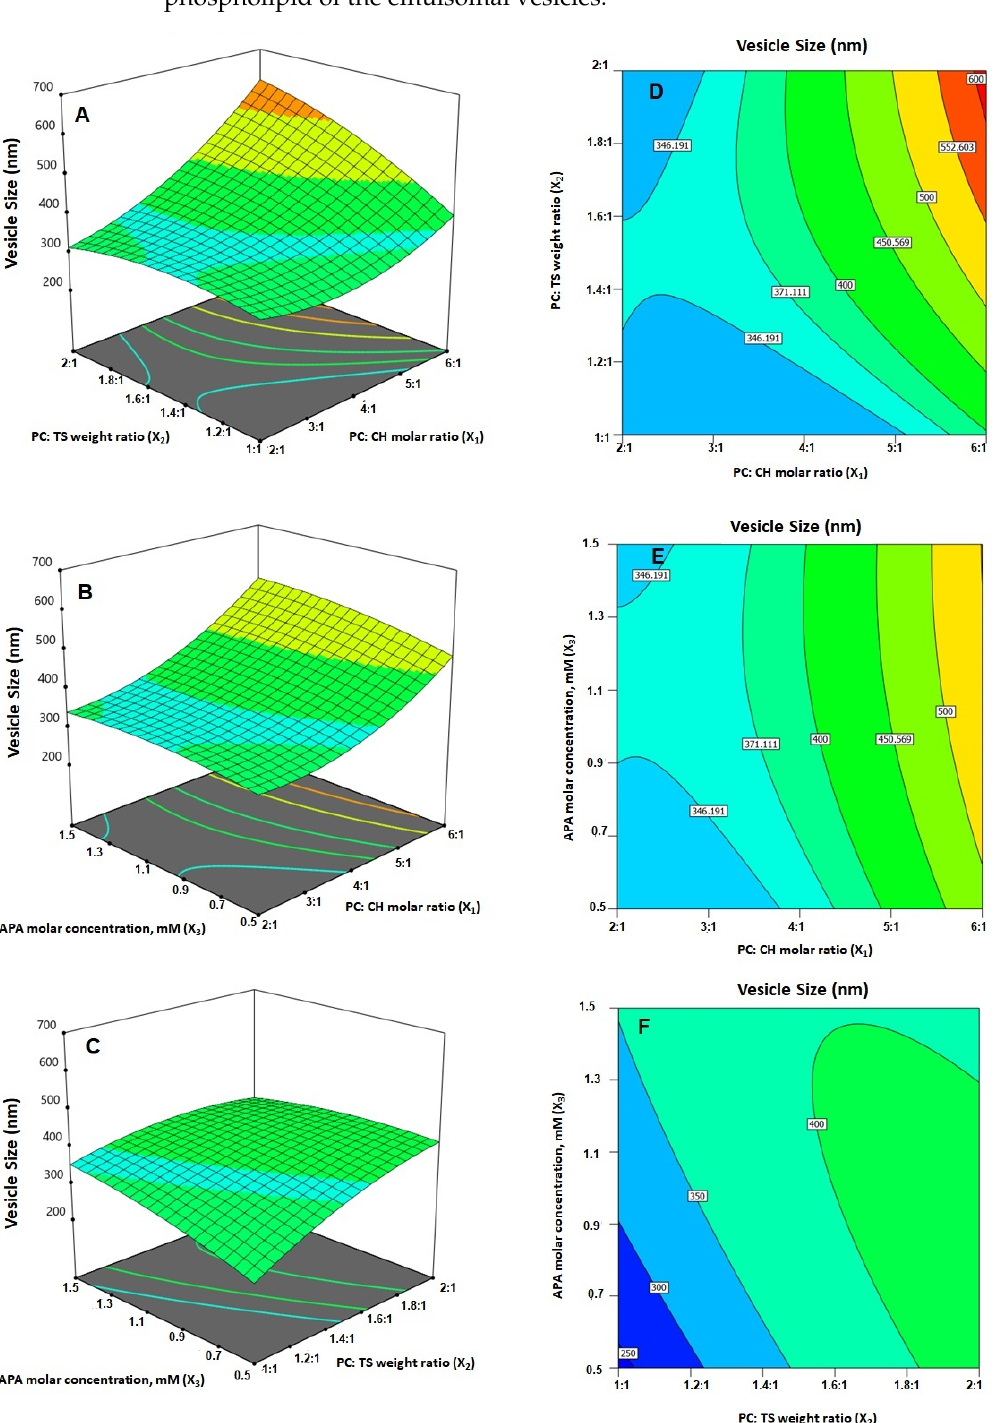
Figure 3. Perturbation graph for the main effects of critical attributes; PC: CH molar ratio (X 1 ), PC: TS weight ratio (X 2 ) and APA molar concentration (X 3 ) on ( A ) vesicle size and ( B ) zeta potential of EGA-EML-APA. Abbreviations: EGA, ellagic acid; EML, emulsomes; APA, apamin; PC: Phospho- lipon 90 G; Cholesterol: CH; TS; Tristearin.